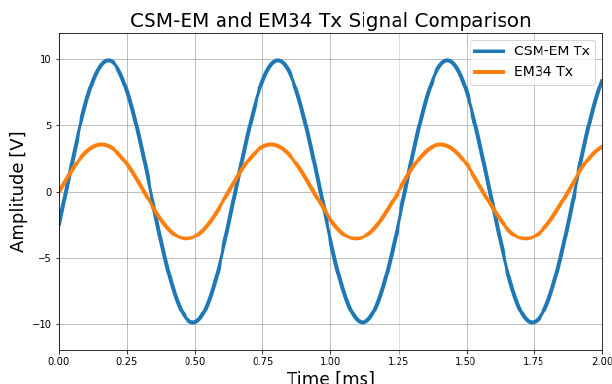
Figure 8. Low-cost CSM R x signal (attached to oscilloscope) using an amplifier gain G = 50 at a 5m T x - R x offset with the EM34 T x (orange) and low-cost CSM-EM T x (blue). The amplitude of the signal received from the CSM-EM T x is over twice that of the EM34 T x